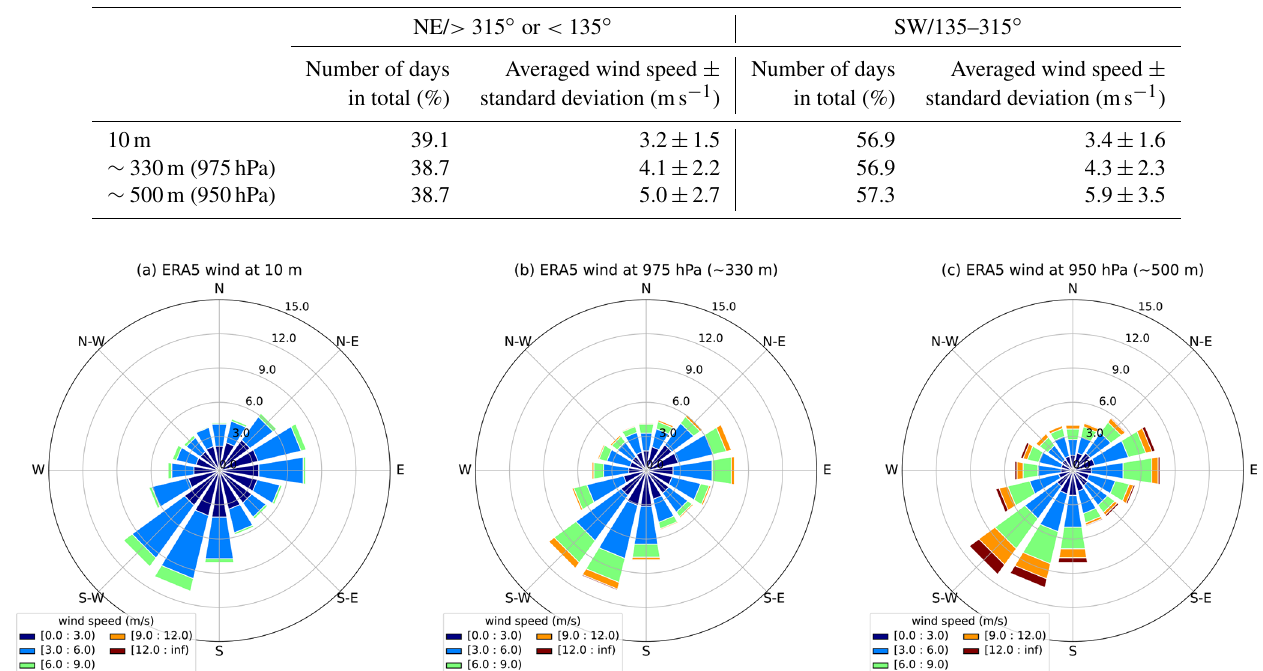
Table 1. Number of days and the averaged wind speed ( ± standard deviation) per specific wind regime during daytime (08:00–18:00UTC) at different vertical levels from November 2017 to December 2020 over the USCB region. The days for the 3-year average coincide with the TROPOMI overpass days.